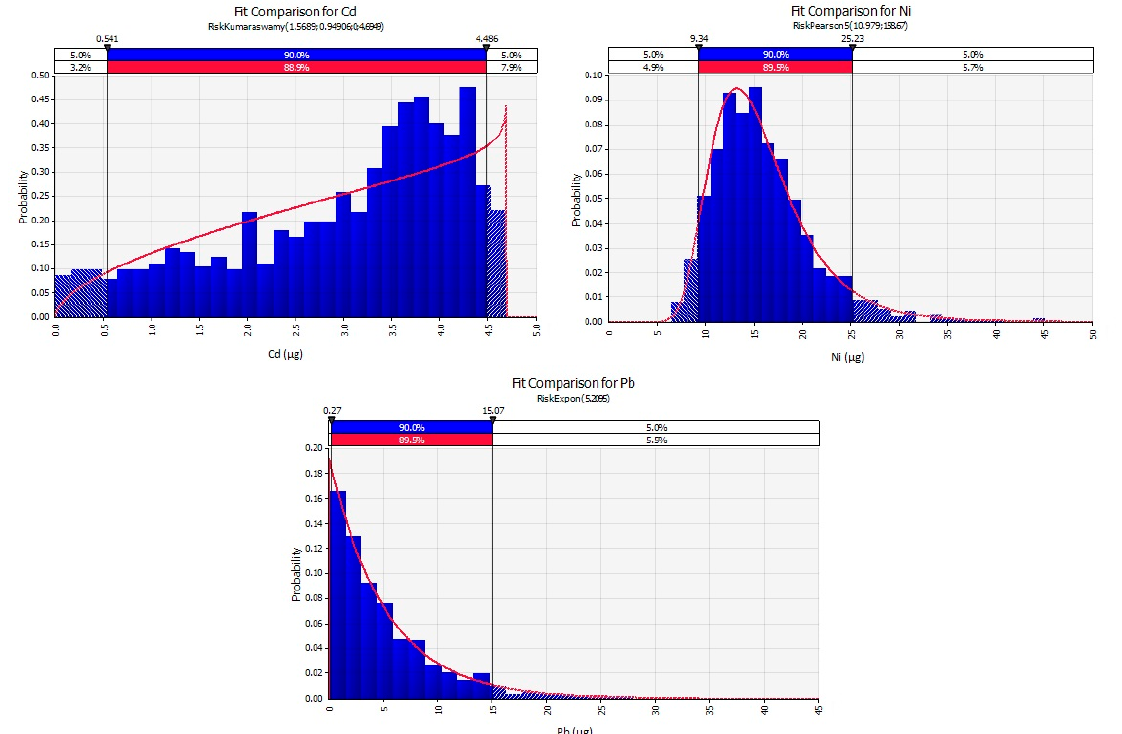
Figure 5. Simulated data and fitted probabilistic distribution for Cd, Ni and Pb in organic Brassicas.